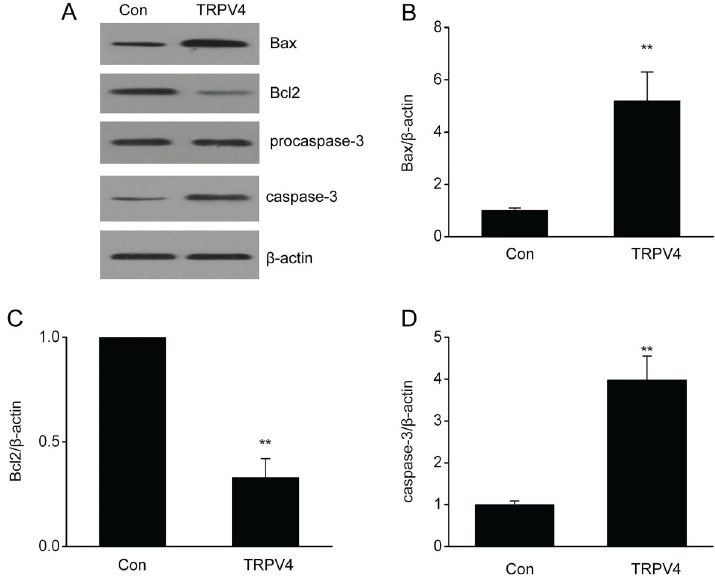
Figure 5. Overexpression of TRPV4 up-regulated cell death associated proteins in a lung cancer cell line. Representative immunoblots ( A ) as well as quantitative assessment of Bax ( B ), Bcl2 ( C ), and caspase-3 ( D ) in A549 cells transfected with control plasmid pcDNA3.1 ( + ) (Con) and plasmid pcDNA3( + )/TRPV4 (TRPV4). Data are reported as means ± SE. **P o 0.01 ( t -test).